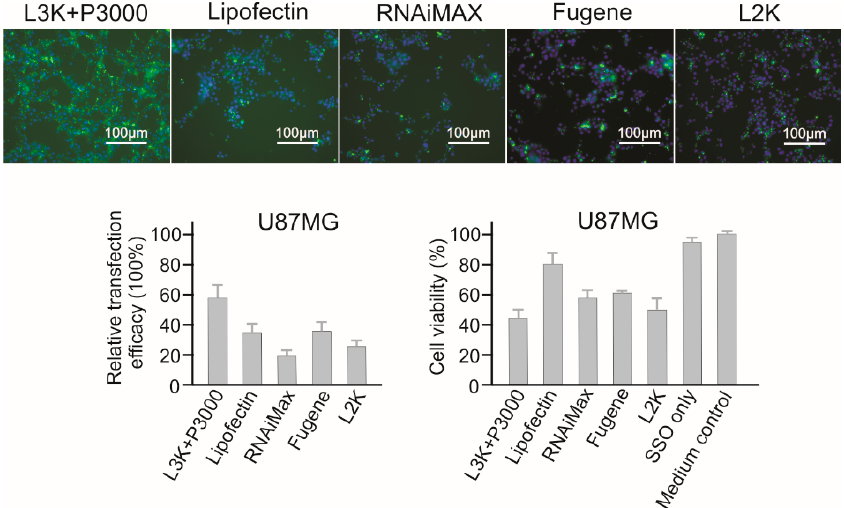
Figure 12. In vitro transfection efficiency and cytotoxicity of different transfection reagents in U87MG cells. L3K: Lipofectamine 3000, L2K: Lipofectamine 2000.